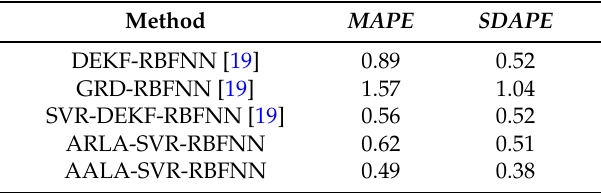
Table 5. MAPE (%) and SDAPE (%) results for prediction methods in Case